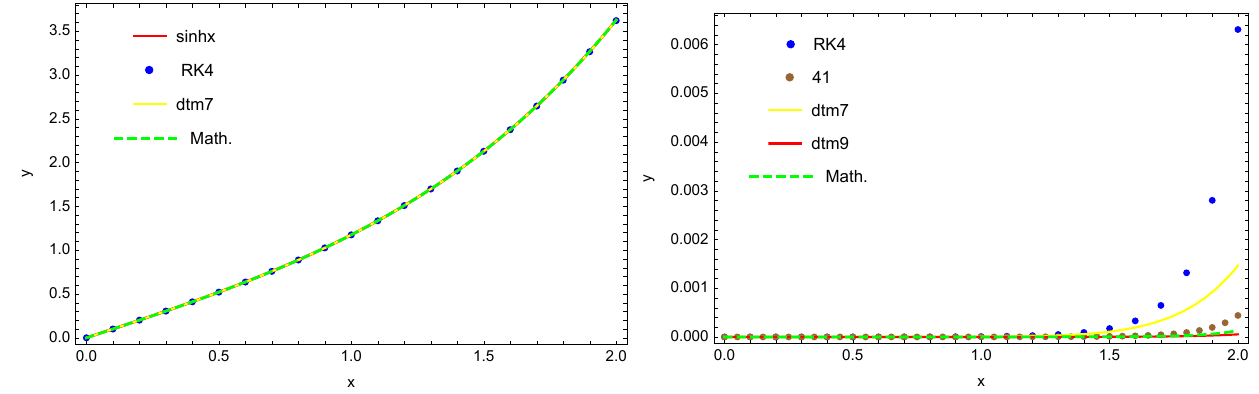
Figure 1. Exact solution and the approximate solutions together with the error ∆ of these